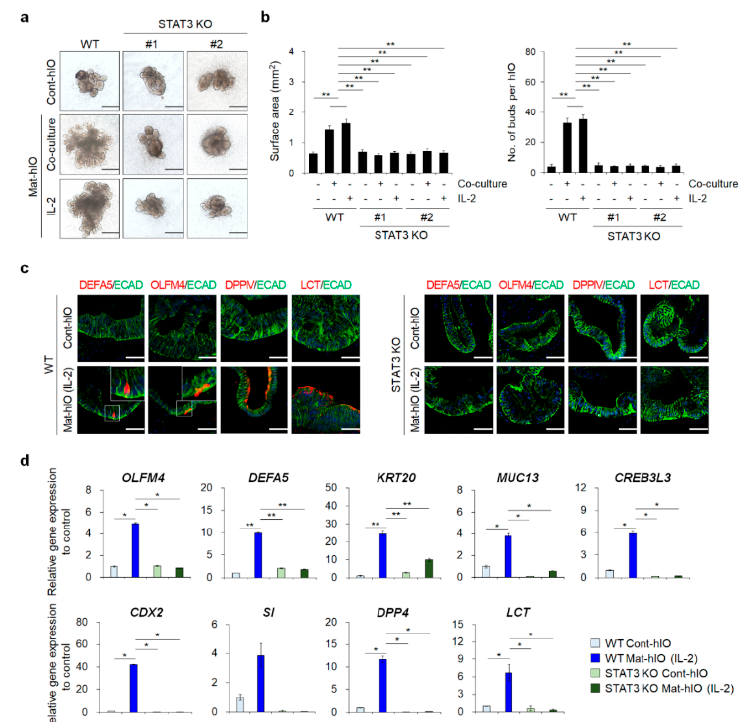
Figure 3. In vitro maturation of STAT3 KO hIOs. ( a ) Representative images of morphological changes during in vitro maturation of hIOs by co-culture with PMA / ionophore-stimulated Jurkat T or treatment with IL-2. Scale bar, 500 µ m. ( b ) Quantitative assessment of the surface area of hIOs (left panel, after two passages of maturation, n = 5 per group) and the number of budding structures per single hIO (right panel, after two passages of maturation, n = 5 per group). Data are presented as the mean value of replicates ± SEM. *** p < 0.001, ** p < 0.01, and * p < 0.05 according to Kruskal–Wallis test. ( c ) Immunofluorescence staining of WT hIOs and STAT3 KO hIOs with an epithelial marker (ECAD) and mature intestinal markers (DEFA5, OLFM4, DPPIV, and LCT) following in vitro maturation. Scale bar, 50 µ m. ( d ) qPCR analysis of intestinal maturation markers in WT Mat-hIOs and STAT3 KO Mat-hIOs by treatment with IL-2 (after three passages of maturation, n = 4 per group). Data are presented as the mean value of replicates ± SEM. *** p < 0.001, ** p < 0.01, and * p < 0.05 according to Student’s t -test.